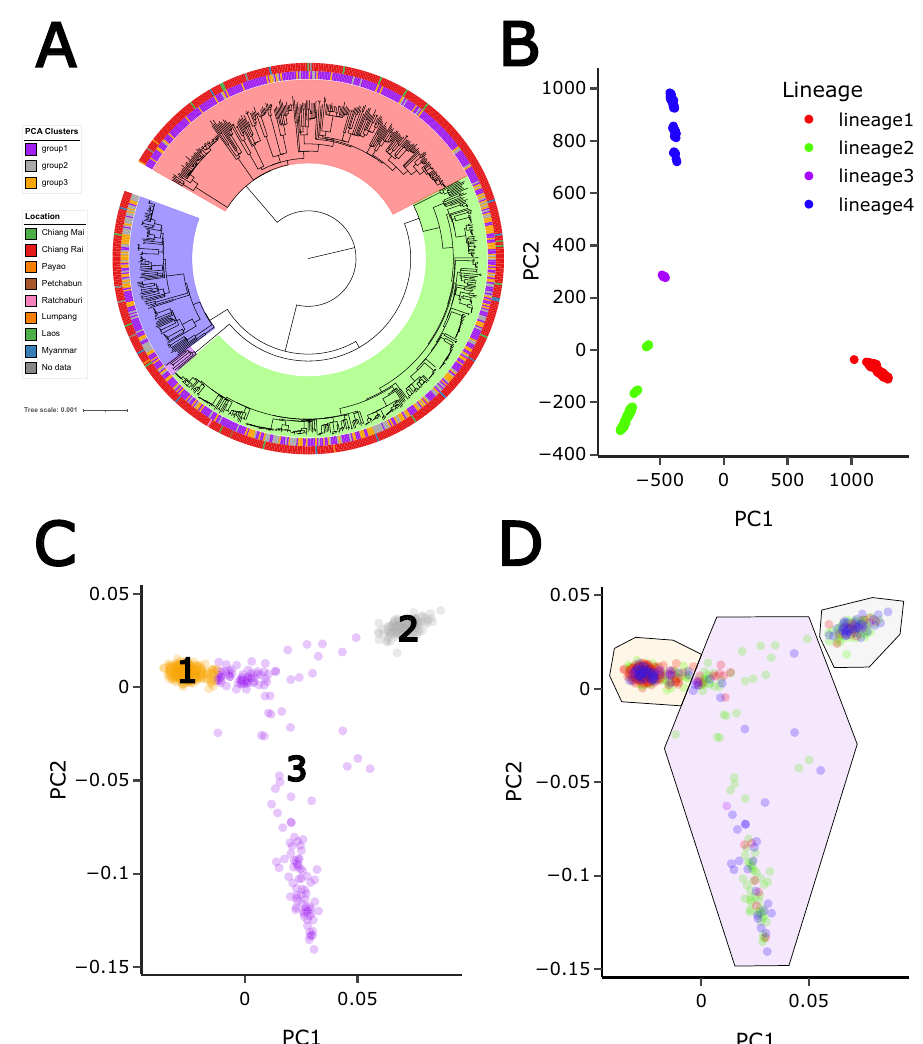
Fig. 1 | Population structure analysis using M. tuberculosis and human geno- types.A Phylogenetictreeofthe M.tuberculosis isolateswithlocationandprincipal component analysis (PCA) clusters annotated; B M. tuberculosis population struc- ture based on the fi rst two principal components; C human PCA with three main